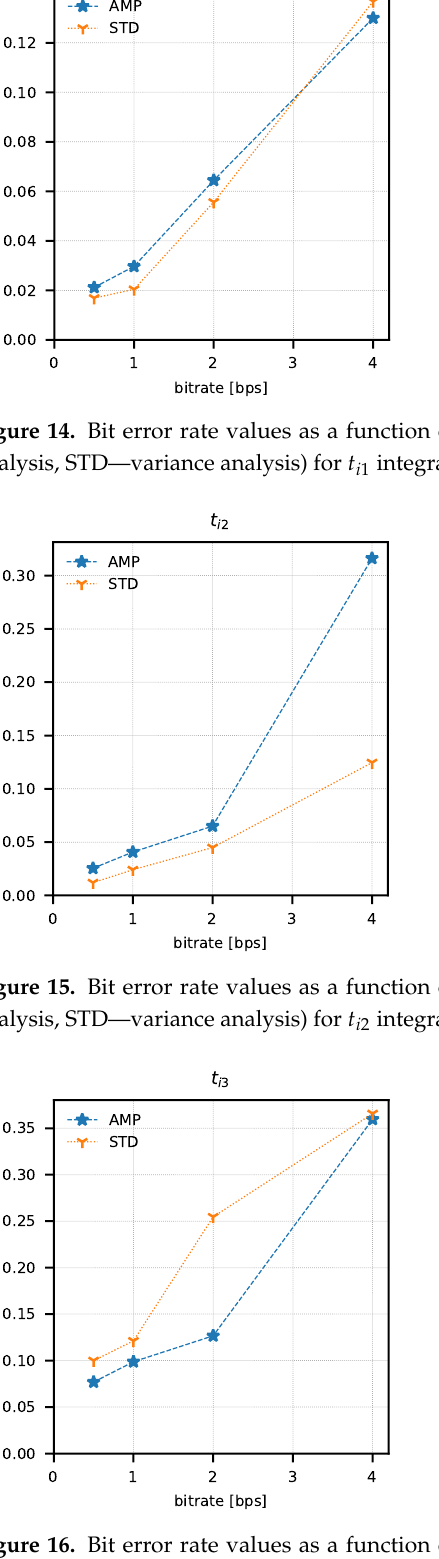
Figure 16. Bit error rate values as a function of bit rate and analysis method (AMP—amplitude analysis, STD—variance analysis) for t i 3 integration time